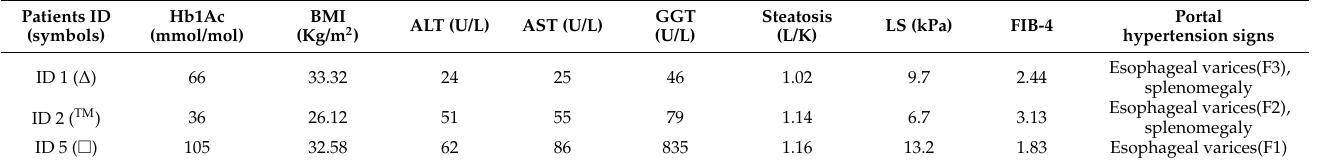
Table 3. Clinical and biochemical evaluation of the three patients with ALMS and signs of portal hypertension. Patients ID